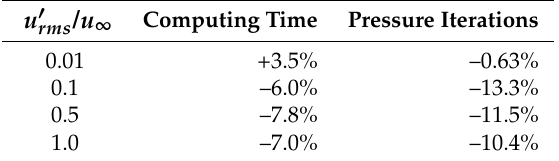
Table 2. Relative change in computational effort with corrected pressure